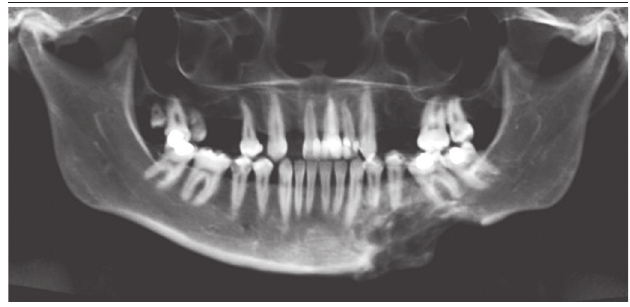
figurE 4 − Postoperative imaging Follow-up with panoramic radiograph, evidencing radiopacity, decrease of lesion extension and presence of bone callus in the